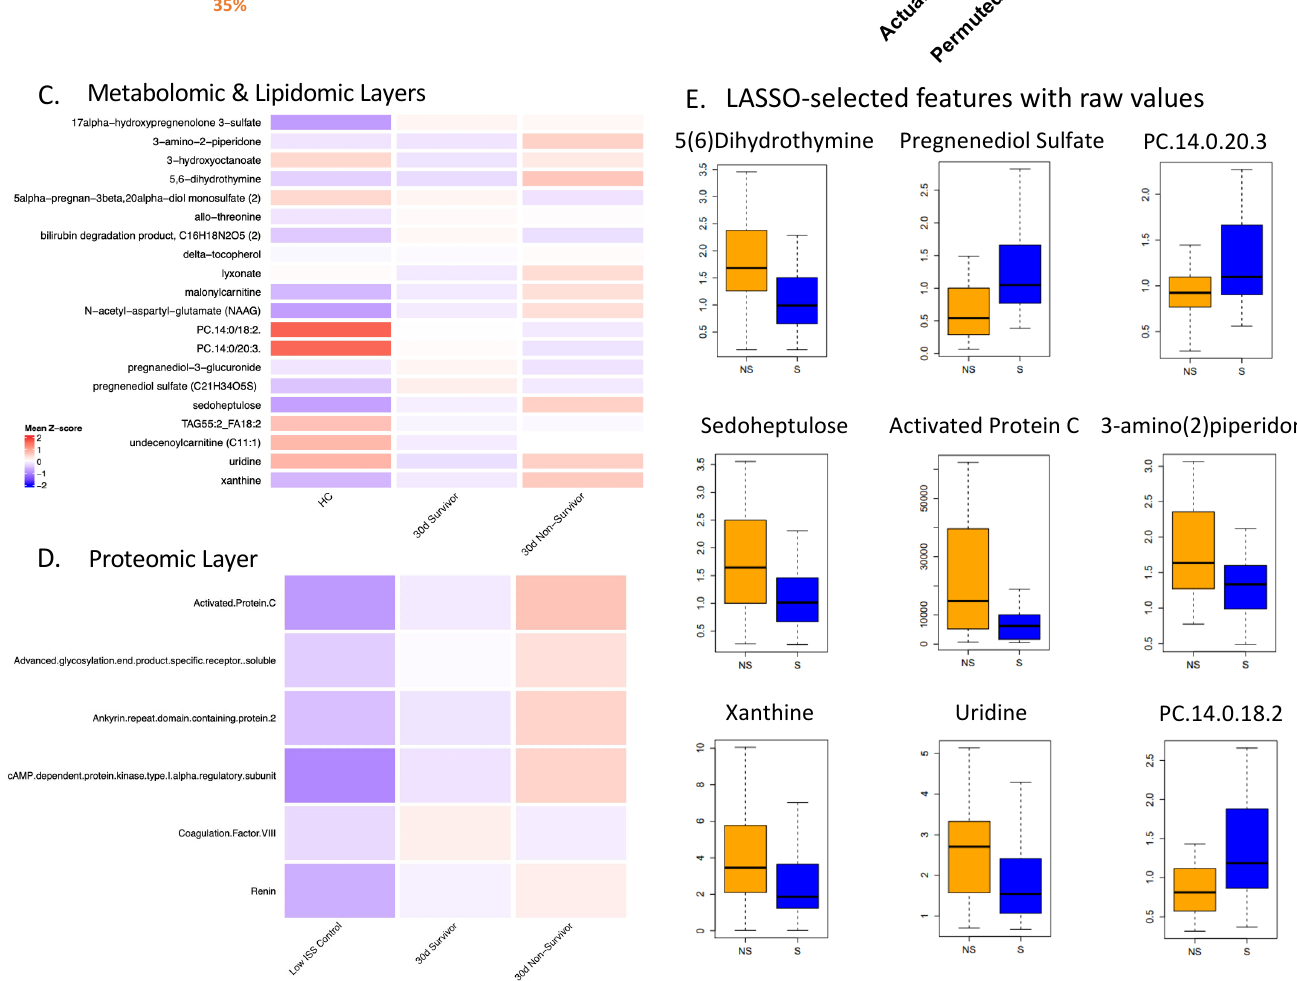
Figure 3. Multi-omic markers predict 30-day survival. ( A ) Breakdown of markers from LASSO model for 30-day survival with a total of 26 features. ( B ) Actual and permuted LASSO AUC graph with an AUC of 0.77. ( C ) Heatmaps of metabolomic and lipidomic layers comparing healthy controls (HC), 30-day survivors, and 30-day non-survivors at the 0 h timepoint, normalized and scaled. ( D ) Numbers of subjects in each group: HC ( n = 17), 30-day survivors ( n = 55), 30-day non-survivors ( n = 57). ( E ) Box plots of LASSO-selected features that are significantly different between survivors and non ‐ survivors with raw value measurement.